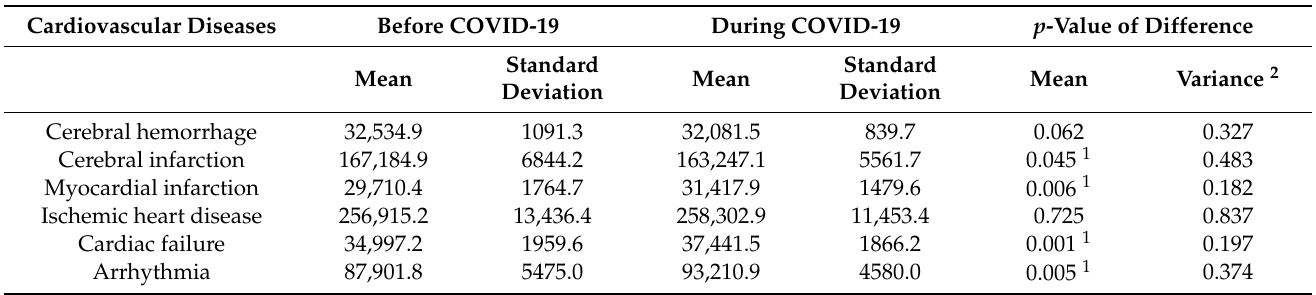
Table 1. Mean and standard deviation of the monthly incidence in six cardiovascular diseases before and during the COVID-19